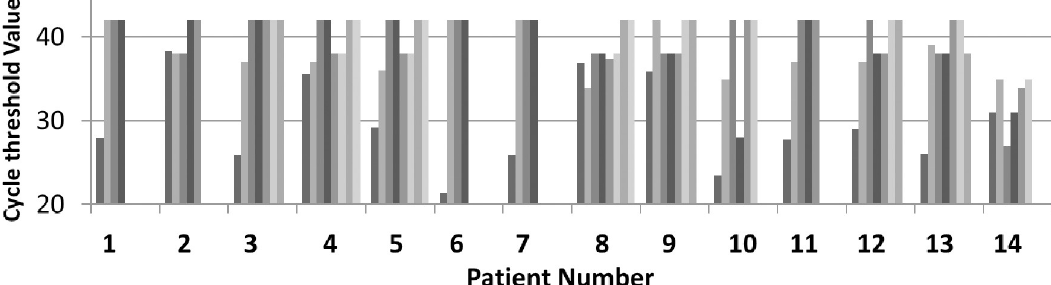
Fig 3. The monitoring of threeSARS-CoV-2 RNA target genes before and after adenosine treatment. Evaluation of SARS-COV- 2 RNA N gene Ct value in respiratory specimens over time. N gene Ct value peaked at the baseline and decreased in responder patients. Above 40 Ct RNA-N genes were considered not detectable. From the left to the right: 1 st column, baseline; 2 nd column, 48 hours; 3 rd column, 120h; up to 15 days (8 th column) from the beginning of the treatment.